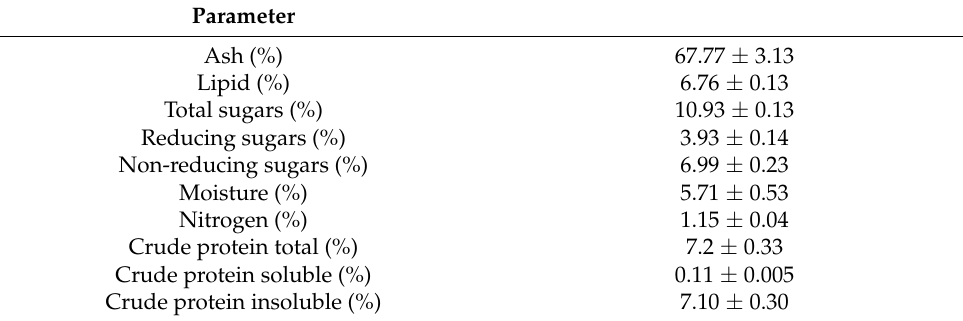
Table 1. Physicochemical parameters of nixtamalized popcorn